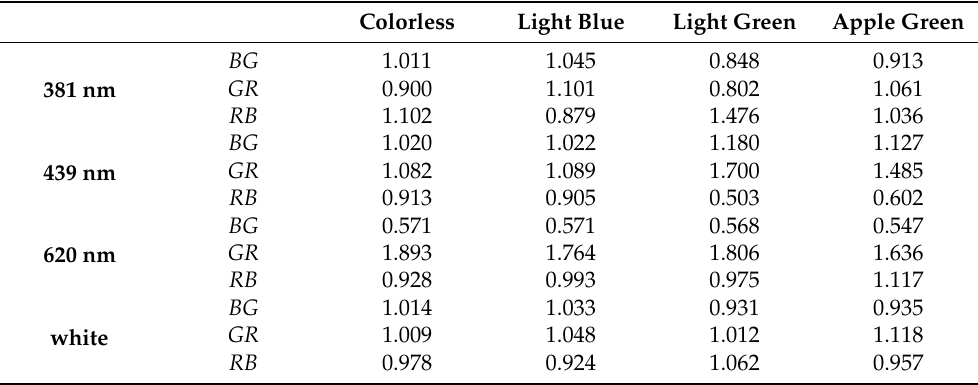
Table 1. The mean values of the color parameters BG , GR and RB of the colorless, light blue, light green and apple green plastics at 381 nm, 439 nm, 620 nm and white transmission light